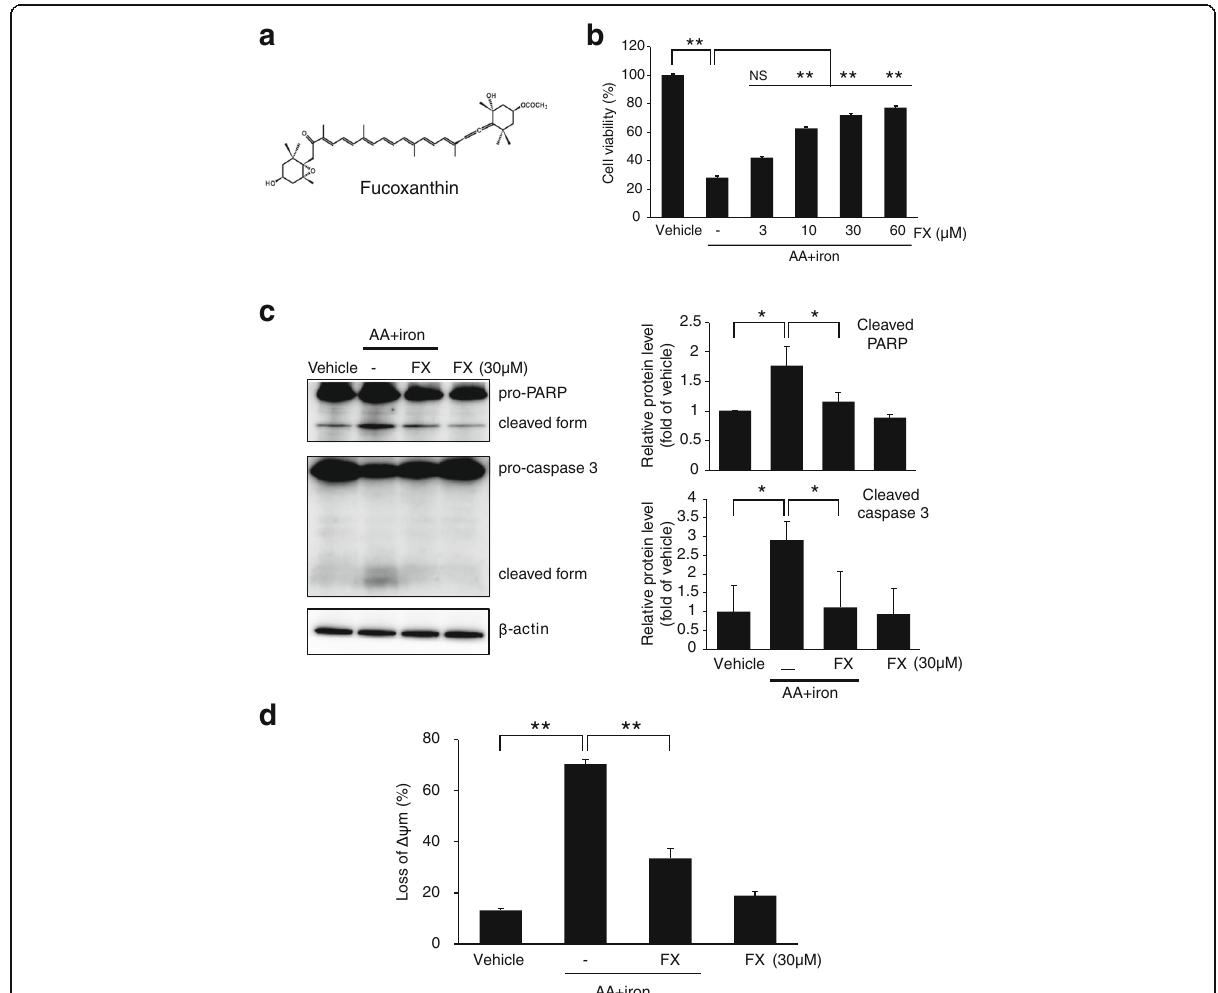
Fig. 2 Fucoxanthin (FX) ameliorates AA + iron-induced cytotoxicity. HepG2 cells were incubated with indicated dose of FX for 1 h and later treated with 10 μ M AA for 12 h, being followed by exposure to 5 μ M iron for 3 h. ( a ) The chemical structure of FX. ( b ) The effects of FX on cell viability was assessed by the MTT assay. ( c ) Expression of proteins associated with apoptosis was determined by western blot analysis. Equal protein loading was verified by β -actin. ( d ) ΔΨ m depolarization monitored by FACS analysis of Rh123 staining. Relative proportions of low Rh-123 intensity (RN1 fractions) are expressed as the mean±S.D. of three separated experiments. For panel b , c and d , data represent the mean±S.D. for the four replicates. ** p